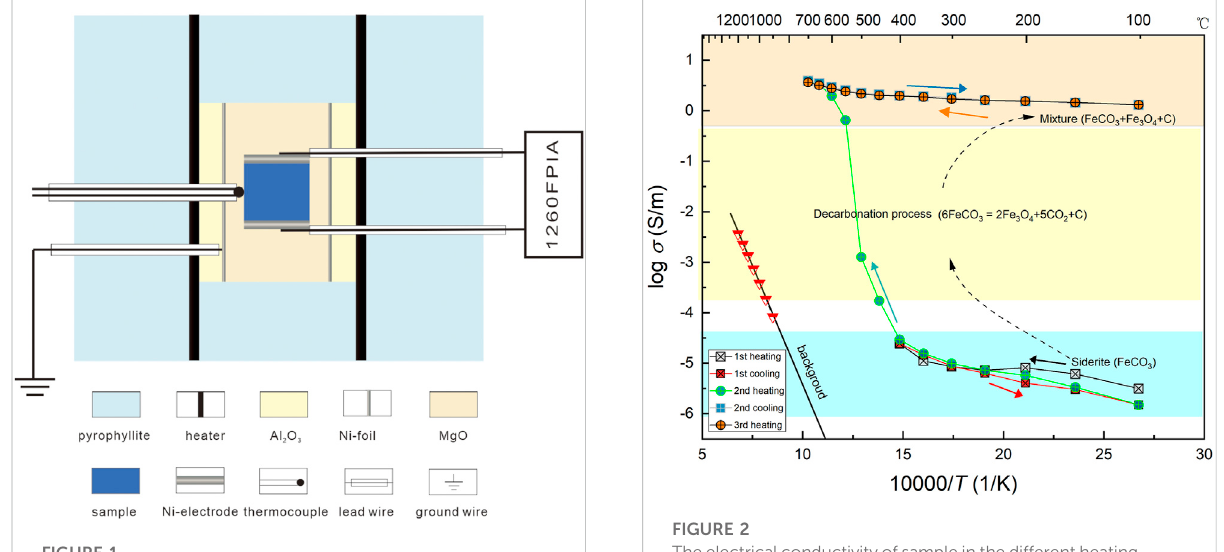
FIGURE 1 Schematic cross section of the cell assembly for conductivity measurement in multi-anvil apparatus.